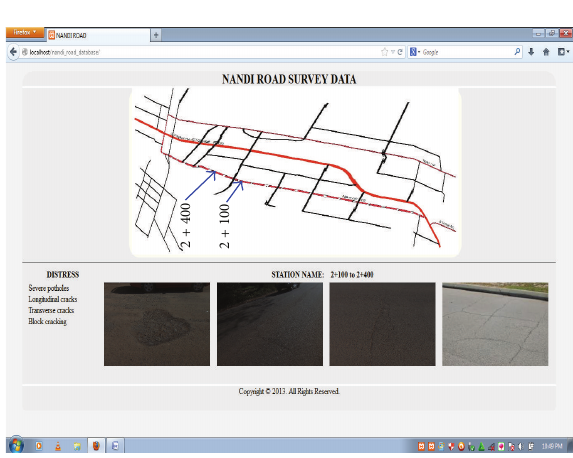
Figure 8: Summary of the distresses report of for the case